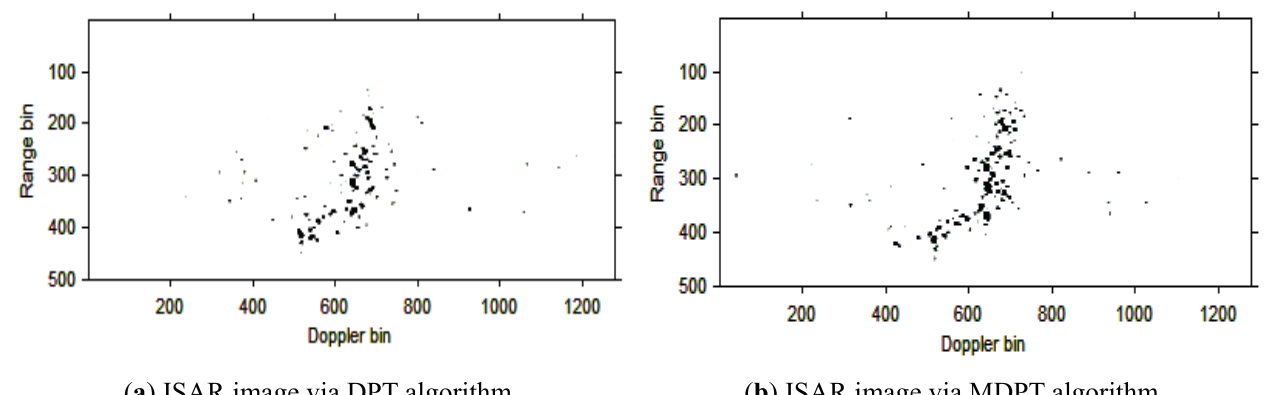
Figure 10. ISAR images at time t = 1.51 s based on DPT and MDPT algorithms.